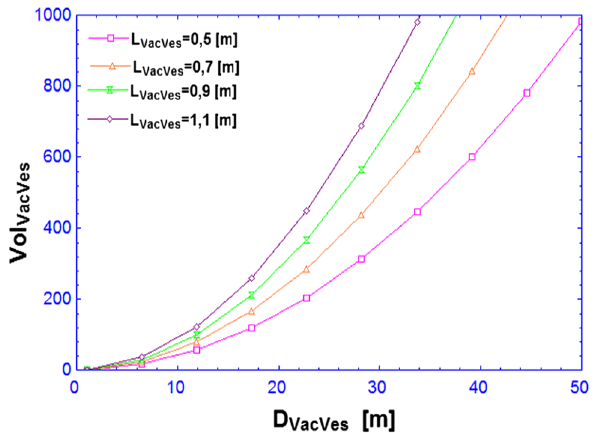
Fig. 17 Volume versus diameter of vacuum vessel